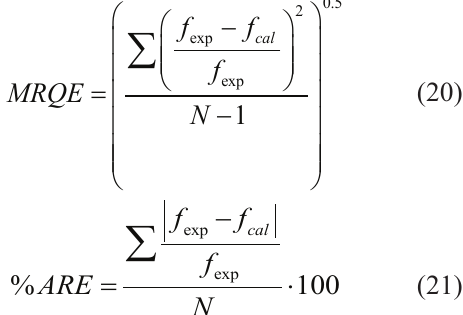
Fig. 6 Residual plot